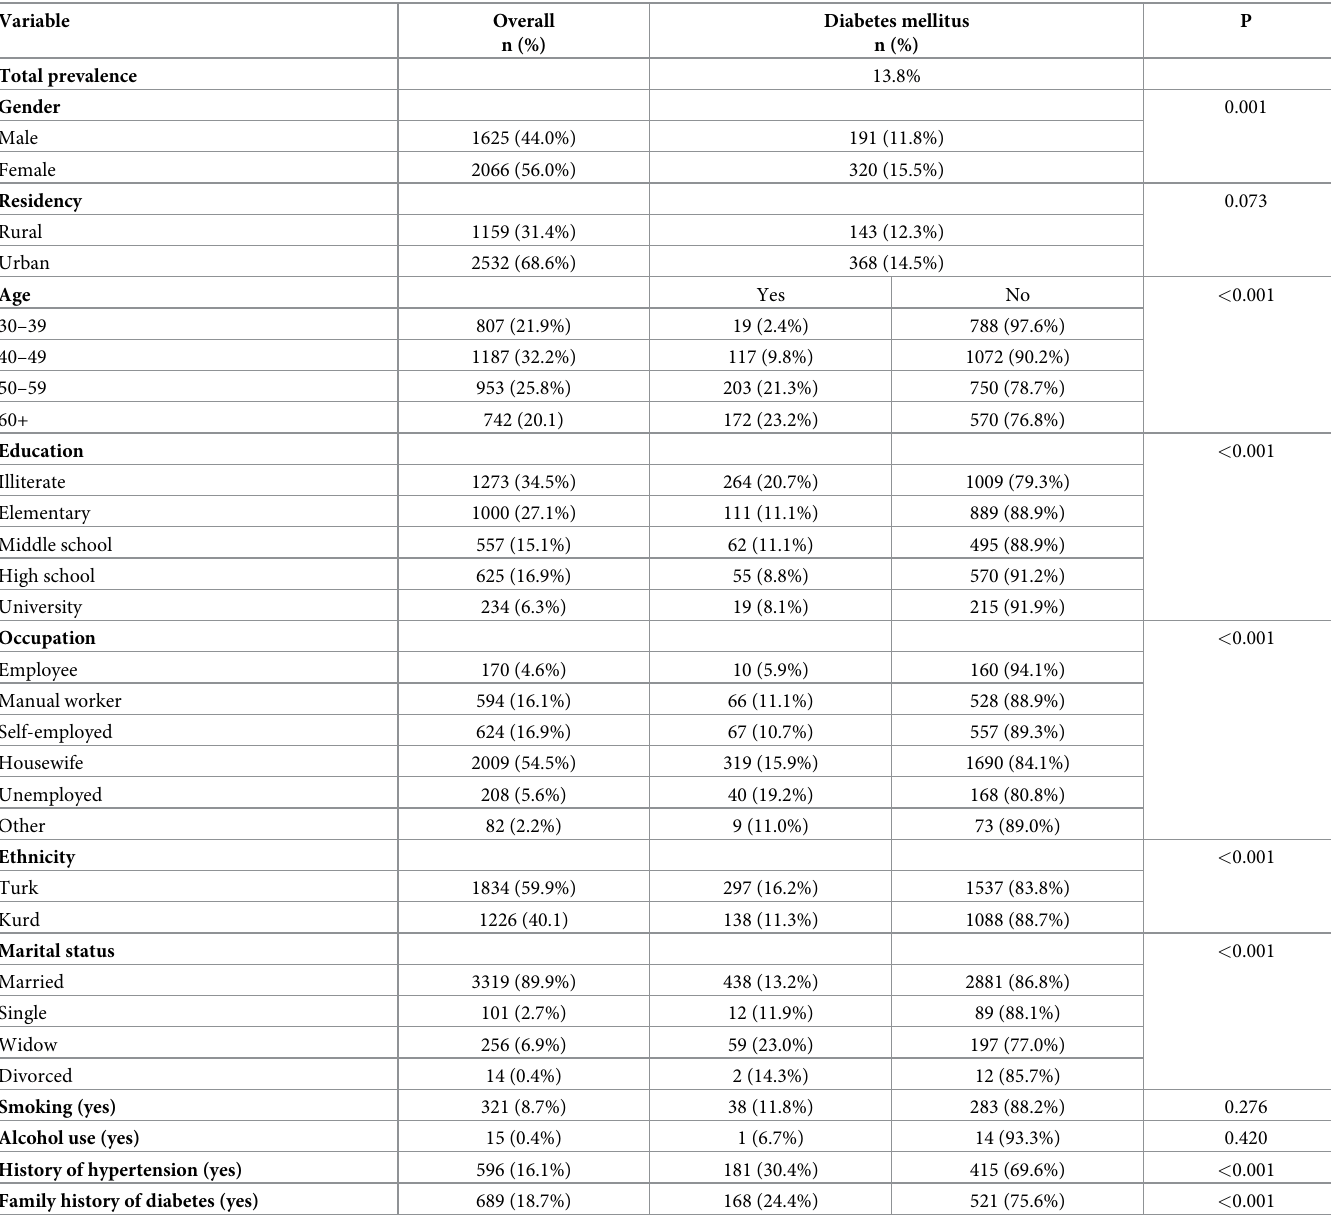
Table 1. Prevalence of type 2 diabetes by gender, residency and socio-demographic characteristics of the respondents (N = 3691). Variable